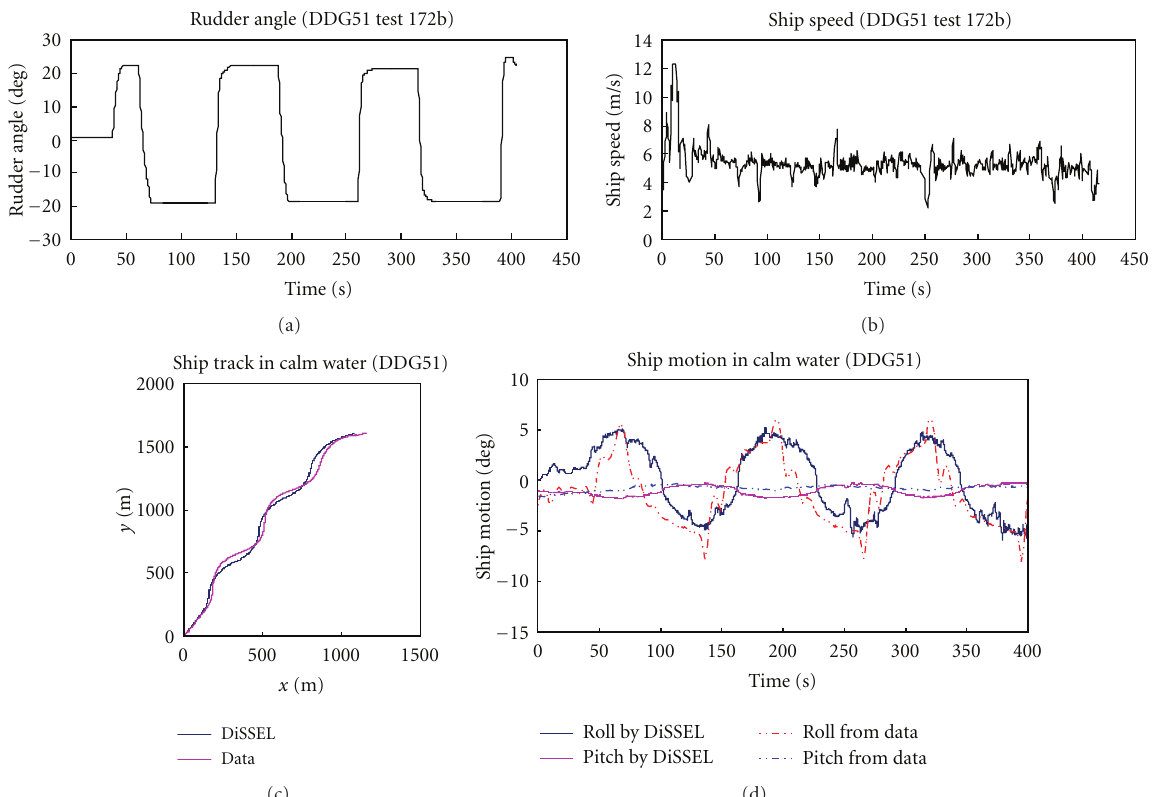
Figure 3: Data input for case 3 are shown in (a) and (b). (a) Rudder angle from data in test 172b, (b) ship speed from data in test 172b. Benchmark simulations for case 3 are shown in (c) and (d). (c) Comparison of ship track between simulation and experimental data in test 172b. (d) Comparison of roll and pitch motions between simulations and data in test